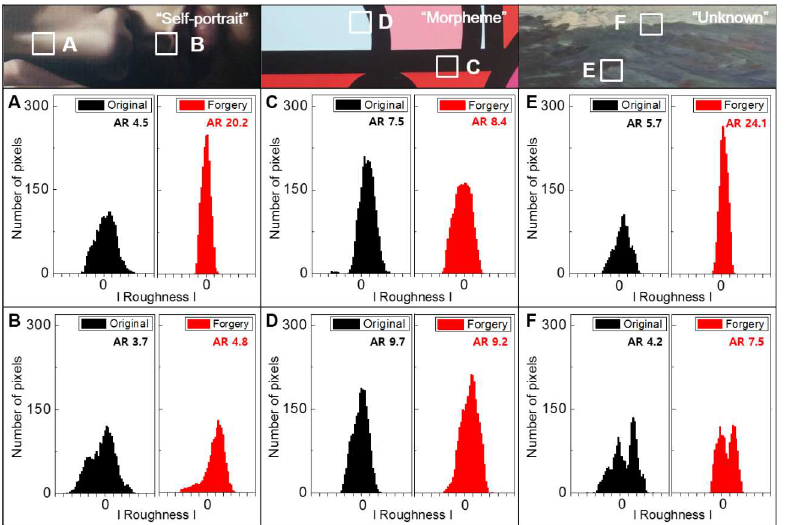
Fig 5. The AR data to distinguish the genuine works from the forgeries. The AR data modifiedfrom the raw topographicimages obtainedfrom the genuineworks (A) Self-portrait , (C) Morpheme , and (E) Unknown . The data measuredfrom the created forgeries of (B) Self-portrait ,(D) Morpheme , and (F) Unknown . The ARs indicatedon the graphs can be used to distinguish the genuineworks from the forgeries(black: originalwork, red: